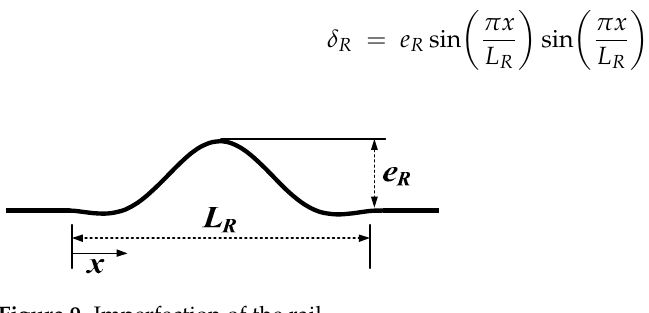
Figure 9. Imperfection of the